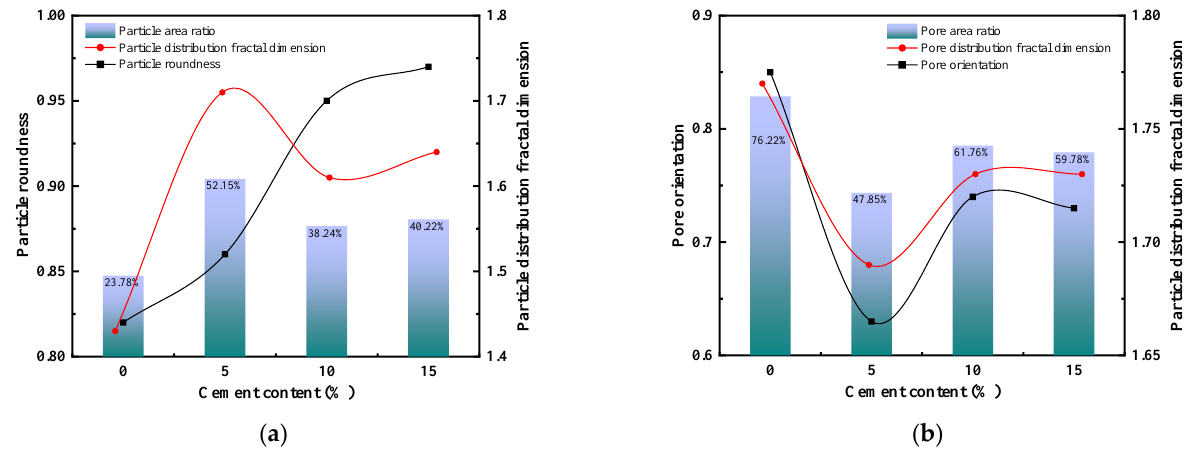
Figure 11. Variation law of microstructure characteristic parameters of muddy clay with permeation grouting. ( a ) Particle characteristics. ( b ) Pore characteristics.